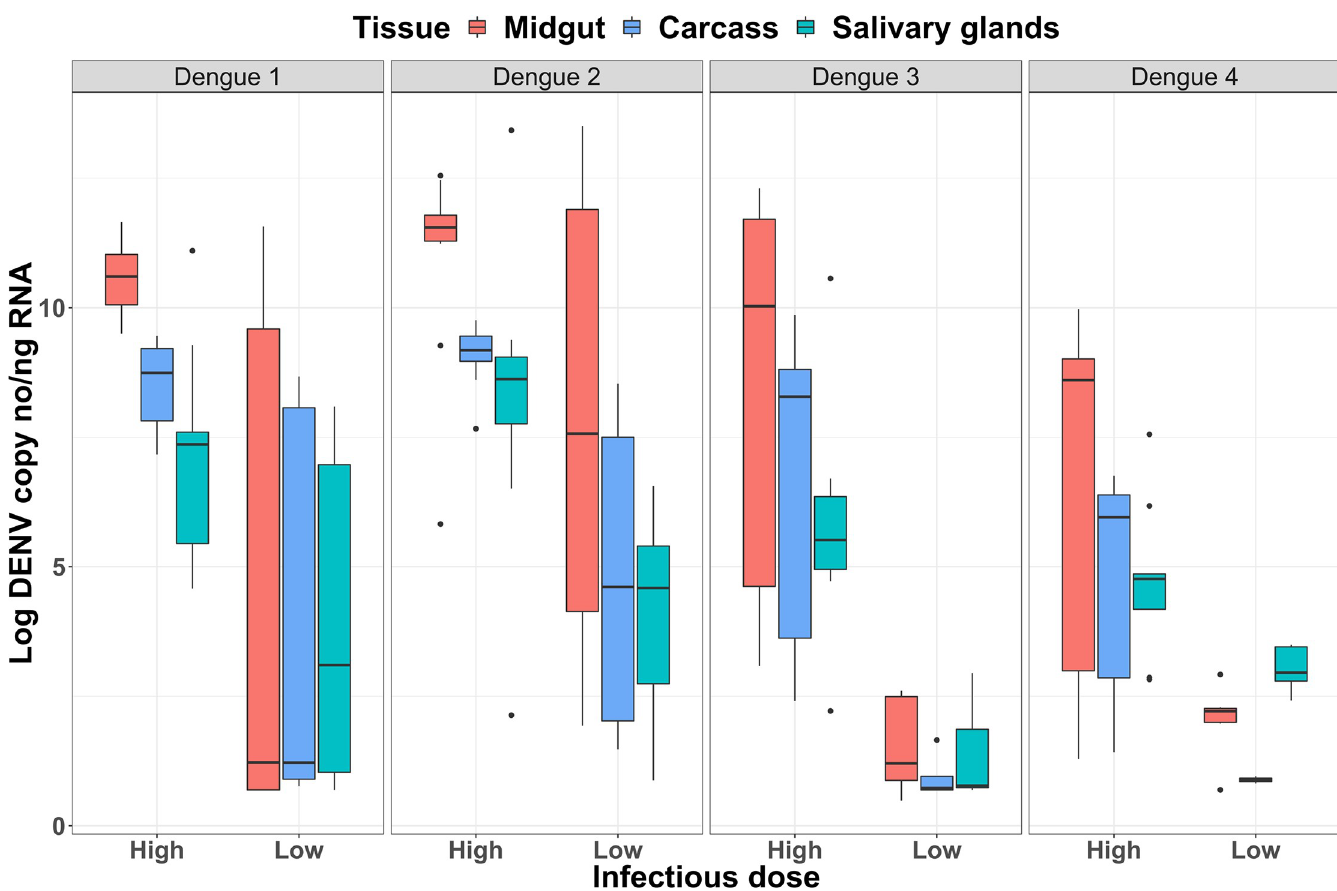
Fig 3. “Trickledown” or declining viral load with tissue progression. Average 20 DPI DENV load for the 4 dengue serotypes across infectious dose and tissues. Box plots show median values ( horizontal line in the box) , 25–75% interquartile range ( upper–lower limits of the box ), 95% range of data ( error lines ).